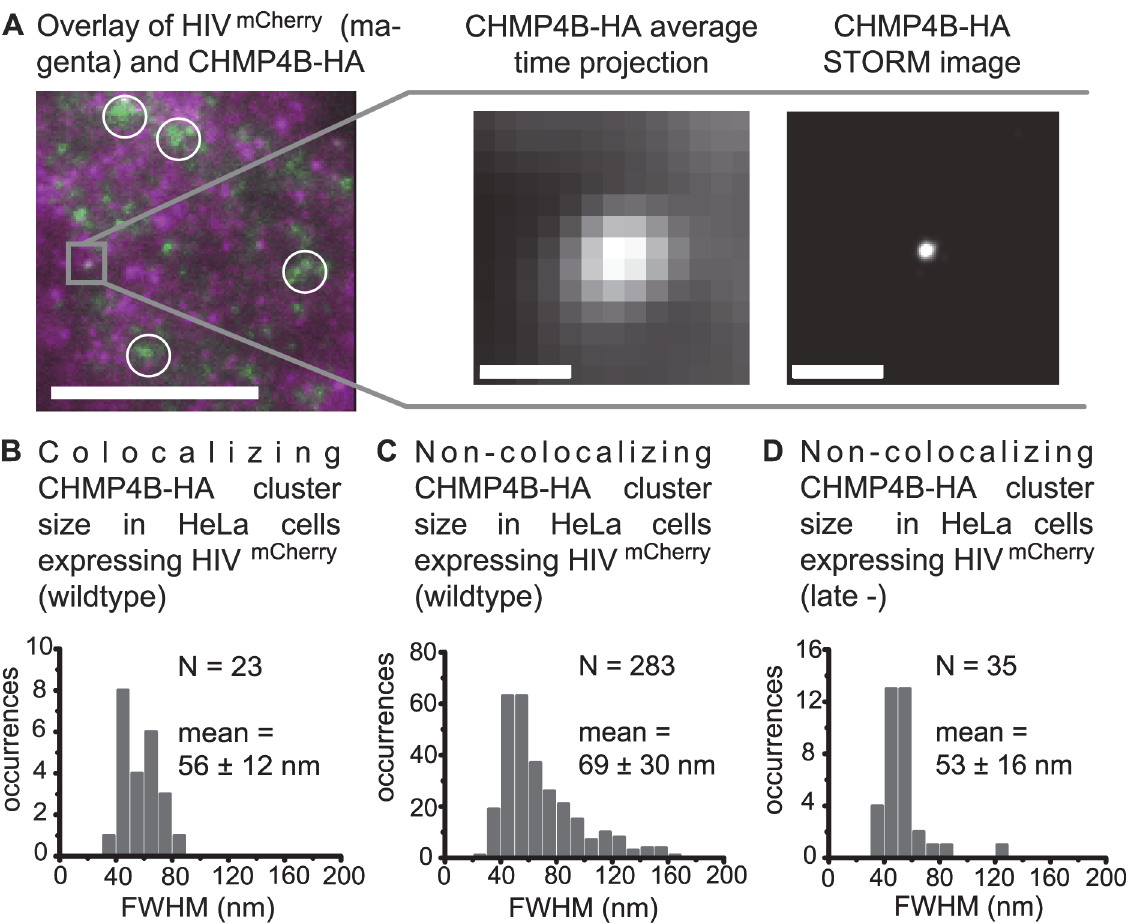
Fig 4. Super-resolution imaging of CHMP4B-HA clusters. HeLa cells were transfected with both HIV:HIV mCherry and CHMP4B-HA and CHMP4B-HA was detected by immunostaining 14 – 15 h post transfection. Cells were imaged by TIRFM. ( A ) Left panel . A time projected overlay of HeLa cells transfected with HIV mCherry (magenta) and CHMP4B-HA (green). The circles indicate partially diffuse CHMP4B clusters at the membrane, which are ignored in further analyses. Scale bar: 10 μ m. Middle panel . A zoomed-in image of a selected CHMP4B-HA cluster (highlighted in grey in the left panel) colocalizing with HIV mCherry . Right panel . The corresponding drift-corrected STORM image. Scale bars: 500 nm ( B ) Size distribution of all CHMP4B-HA structures colocalizing with HIV mCherry with an average cluster size (FWHM) of 56 ± 12 nm. ( C ) Size distribution of all non-colocalizing CHMP4B-HA clusters in cells co-expressing HIV mCherry wildtype with an average cluster size (FWHM) of 69 ± 30 nm. ( D ) Size distribution of all non-colocalizing CHMP4B clusters in cells co-expressing HIV mCherry late- with an average cluster size (FWHM) of 53 ± 16 nm.